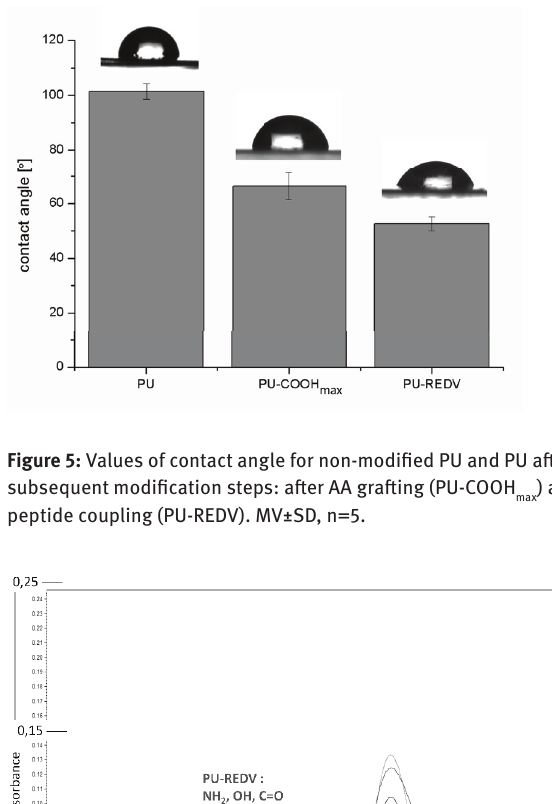
Figure 6: FTIR-ATR spectra of materials: PU, PU-COOH